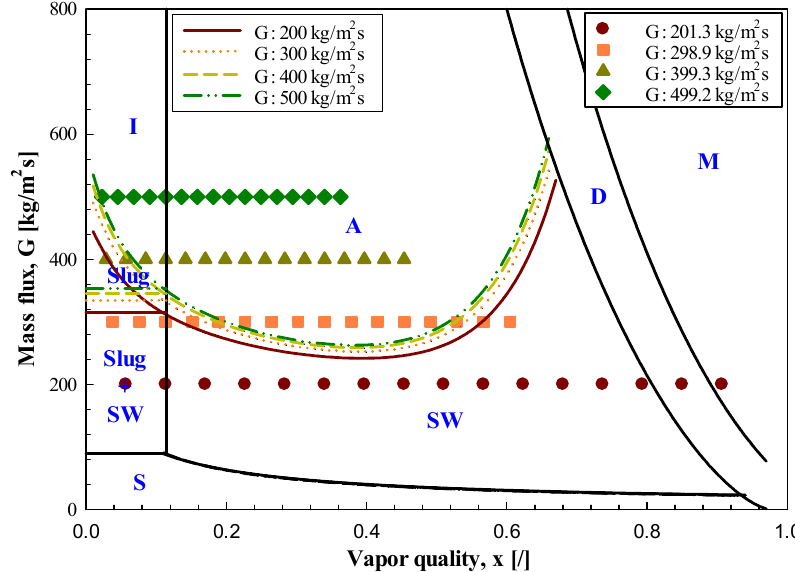
Figure 4. Flow pattern map for R744 according to various mass fluxes at constant saturation temperature ( − 20 ◦ C) and heat flux (20 kW/m 2 ).